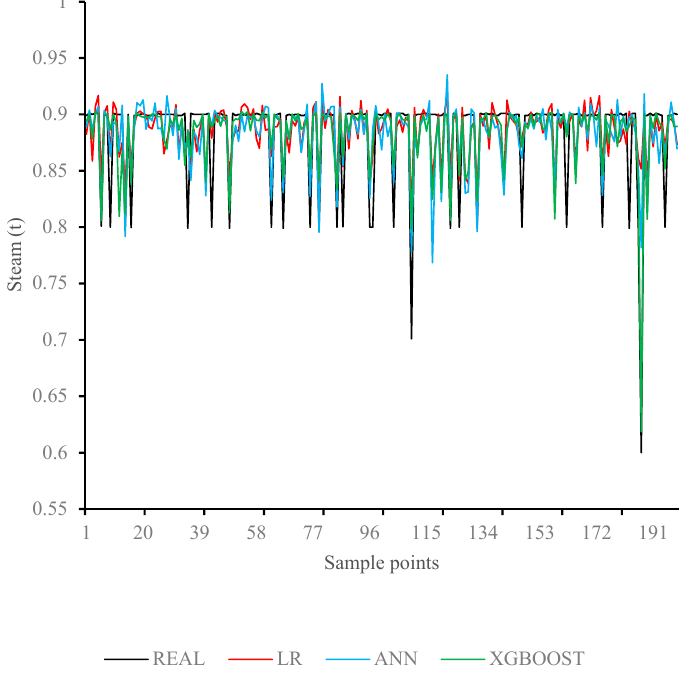
Figure 8. Real steam consumption and predicted steam consumption.